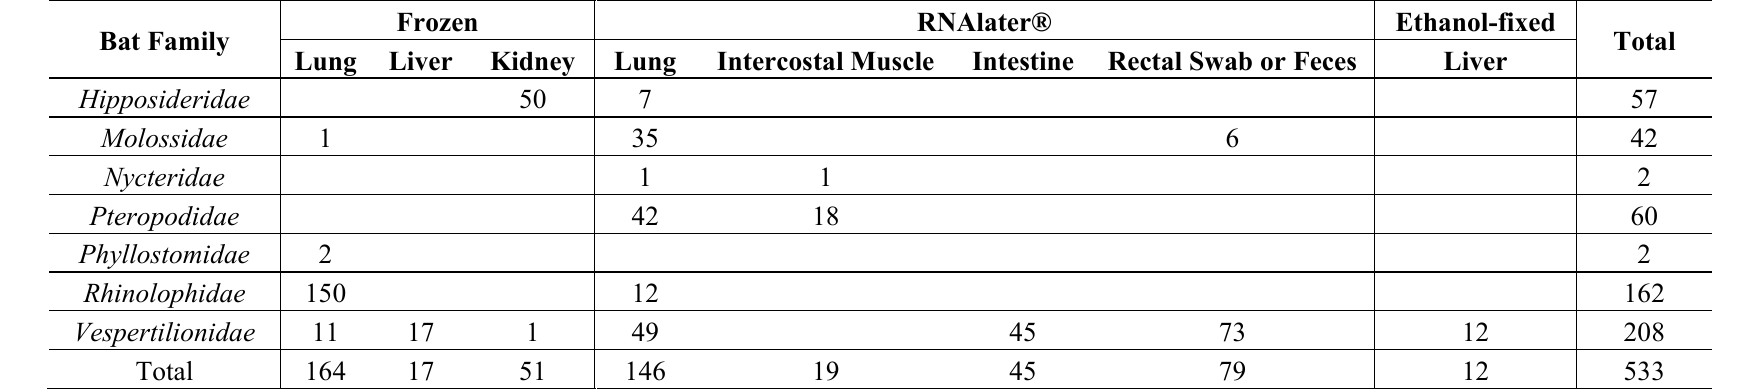
Table 1. Specimen types analyzed for hantavirus RNA.